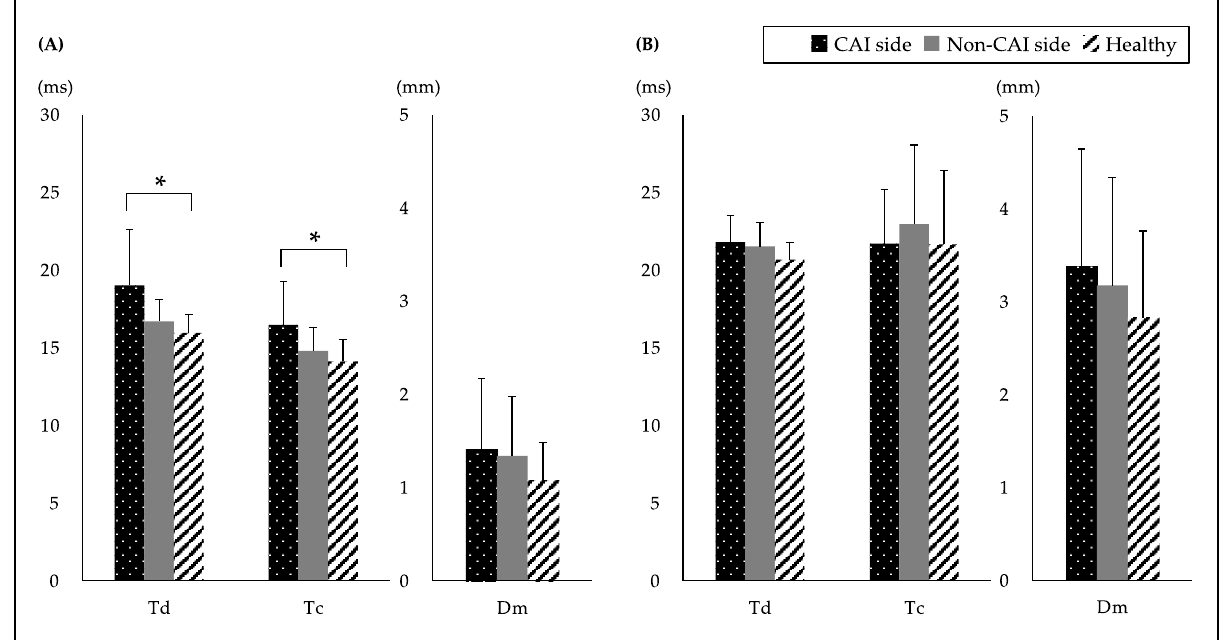
Figure 1. Comparison of the TMG values between the CAI and healthy groups of subjects. TMG values of the ( A ) peroneus longus (PL) and ( B ) tibialis anterior (TA) are shown. Data are expressed as the mean ± SD. * p < 0.05. (ms) means the time. (mm) means the displacement. CAI: chronic ankle instability; Td: delay time; Tc: Contraction time; Dm: maximal displacement. One-factor ANOVA test: Td of the PL, p = 0.033, η 2 = 0.25, observed power (OP) = 0.92; Tc of the PL, p = 0.025, η 2 = 0.21, OP = 0.70; Dm of the PL, p = 0.416, η 2 = 0.53, OP = 0.06; Td of the TA, p = 0.419, η 2 = 0.10, OP = 0.20; Tc of the TA, p = 0.701, η 2 = 0.02, OP = 0.31; Dm of the TA, p = 0.469, η 2 = 0.04, OP = 0.08. Tukey post-hoc analysis for Td of the PL: CAI side vs. non-CAI side, p = 0.132, d = 0.85; CAI side vs. healthy, p = 0.037, d = 1.12; non-CAI side vs. healthy, p = 0.355, d = 0.59. Tukey post-hoc analysis for Tc of the PL: CAI side vs. non-CAI side, p = 0.122, d = 0.75; CAI side vs. healthy, p = 0.024, d = 1.04; non-CAI side vs. healthy, p = 0.712, d = 0.46.